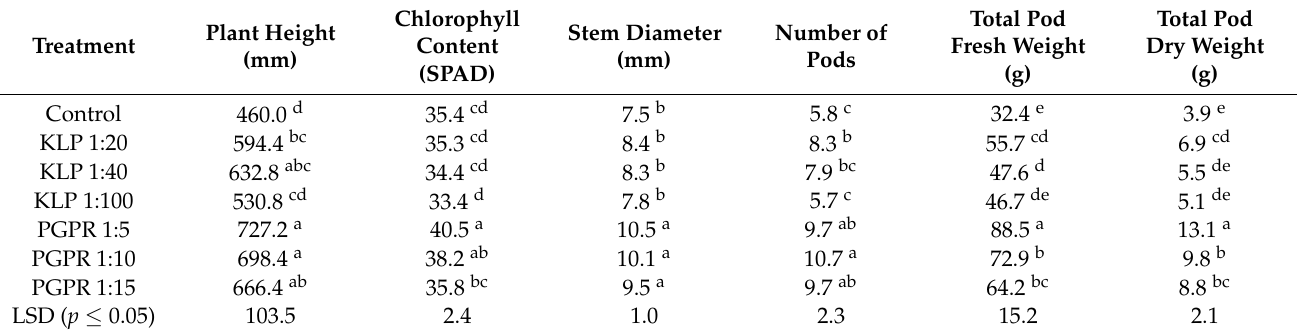
Table 2. Effect of biostimulant treatment on Abelmoschus esculentus growth and yield. In each column, values followed by different letters indicate statistically significant ( p ≤ 0.05)